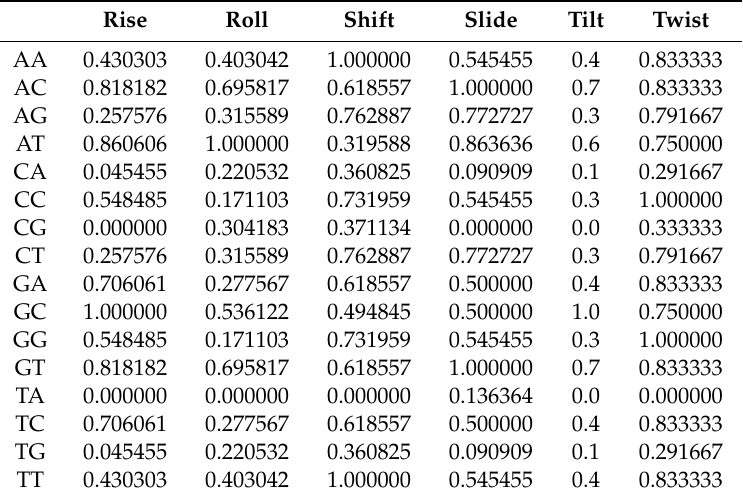
Table 1. Physicochemical